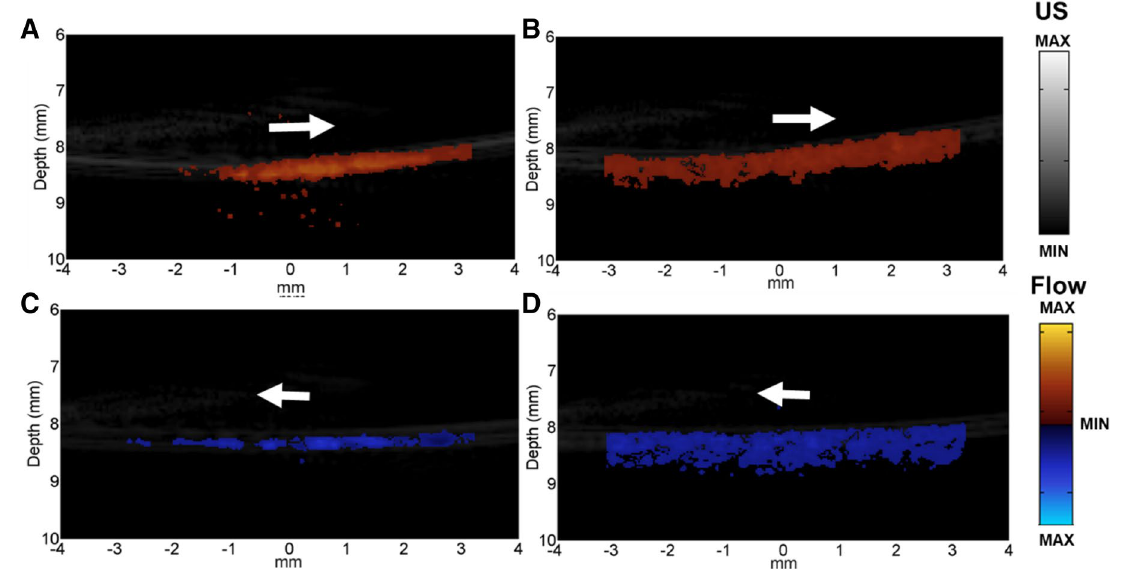
Figure 4. Comparison of the contrast effects of US flow between microbubbles (Sonovue™) and microdroplets: ( A ) and ( C ) are flow images of microbubbles (Sonovue™). ( B ) and ( D ) are the flow images of microdroplets. The white arrow indicates the flow Fig. 5B. The enhancement of the PA not only showed a clearer boundary of the vascular structure at the surface, but also exposed deeper PA targets (i.e. in the red dashed circles in Fig. 5B) that was not reached by this modality before. The data in the dashed squares was evaluated quantitatively and will be covered in Fig. 57. In the second step of the in vivo studies, nude mouse with subcutaneous tumor was employed to illustrate how the hydrogel based dual-modality contrast agents achieved long term enhancement, especially in US flow imaging, and revealed more information about the vasculature system around the tumors. A nude mouse with 1.2 cm subcutaneous tumor was selected for this study. Agarose gel with 5 mm thickness was put on top of the tumor with ultrasound gel applied on both sides too.